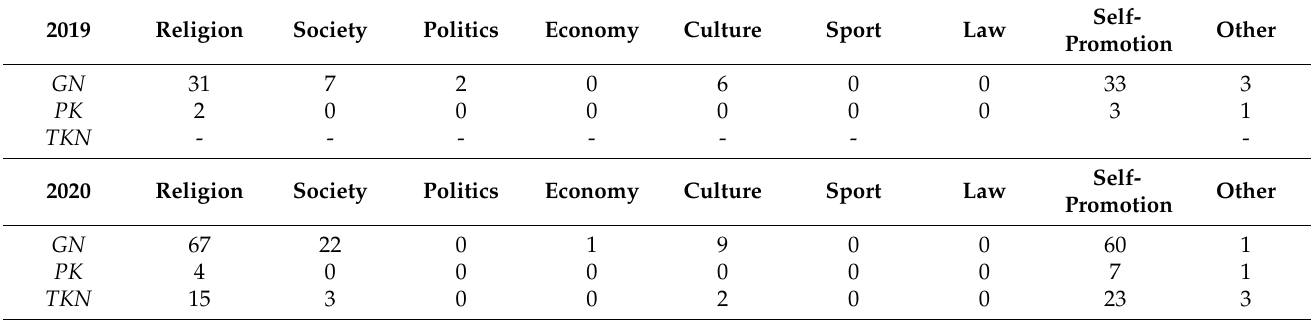
Table 6. Topics of posts on the Instagram profiles of the selected Catholic weeklies